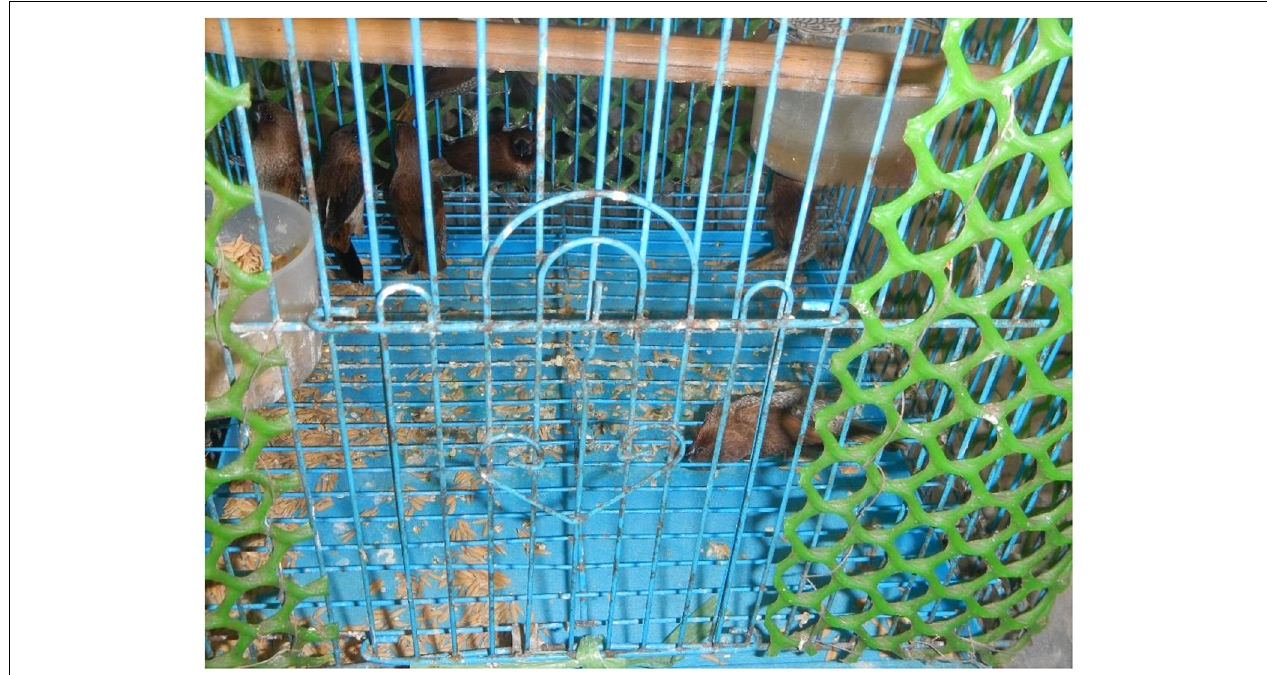
FIGURE 3 | Dead bird inside cage at Huong Pagoda, HaNoi, Vietnam (Magellan